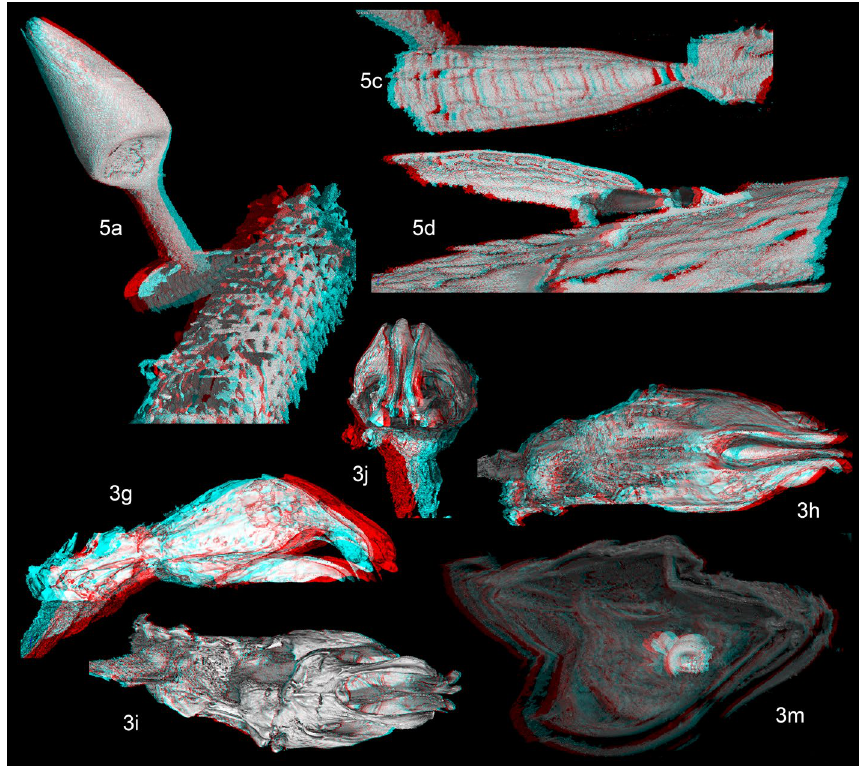
Figure 2. Anaglyph pictures of 2g–2j; 2m; 4a; 4c; 4d. † Proptomaphaginus alleni and † Columnomyces electri , pictures in anaglyph red/cyan of three-dimensional view of selected morphological details. The numbering is the same as the corresponding flat